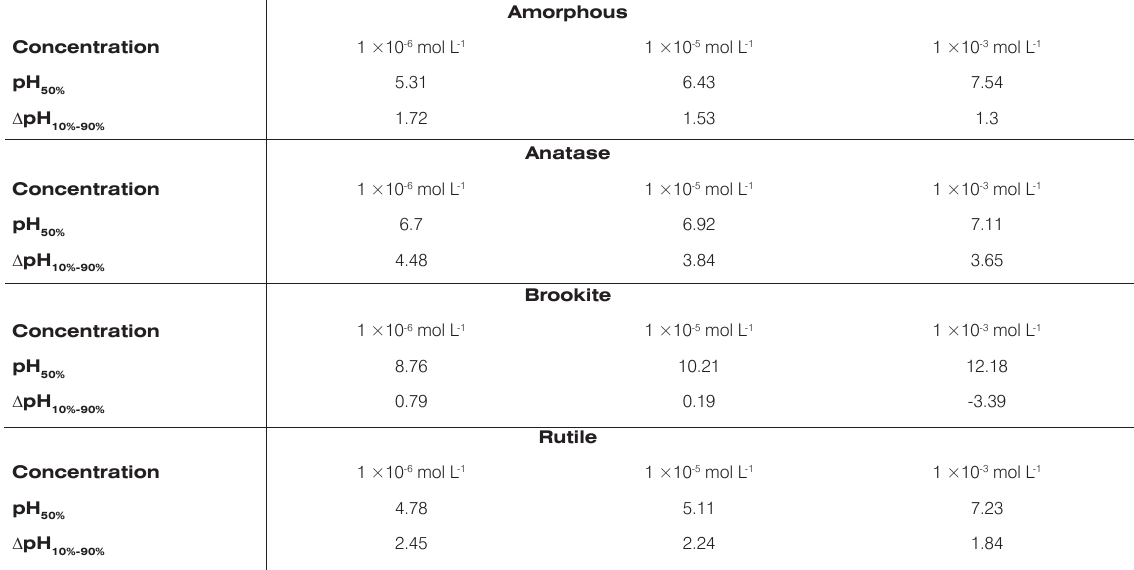
Table 4. Parameters of Zn(II) adsorption for monophase samples.